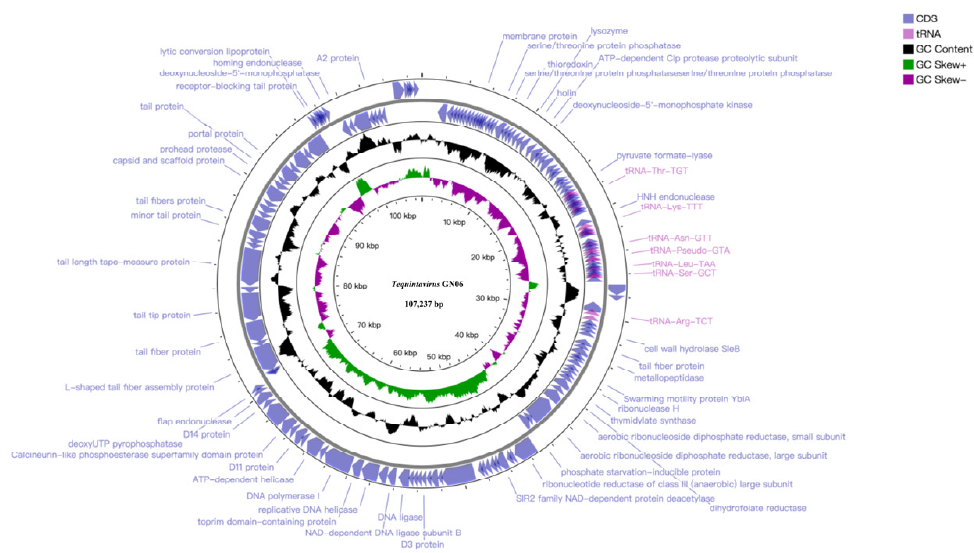
Figure 4. Genome map of phage vB_EcoS_GN06, the genome of phage GN06 depicted in the circular. These arrows represent 155 CDS, among which 32 CDS can be predicted to function. In addition, the map shows GC skew and content about the genome. Note: Not marked as hypothetical protein .